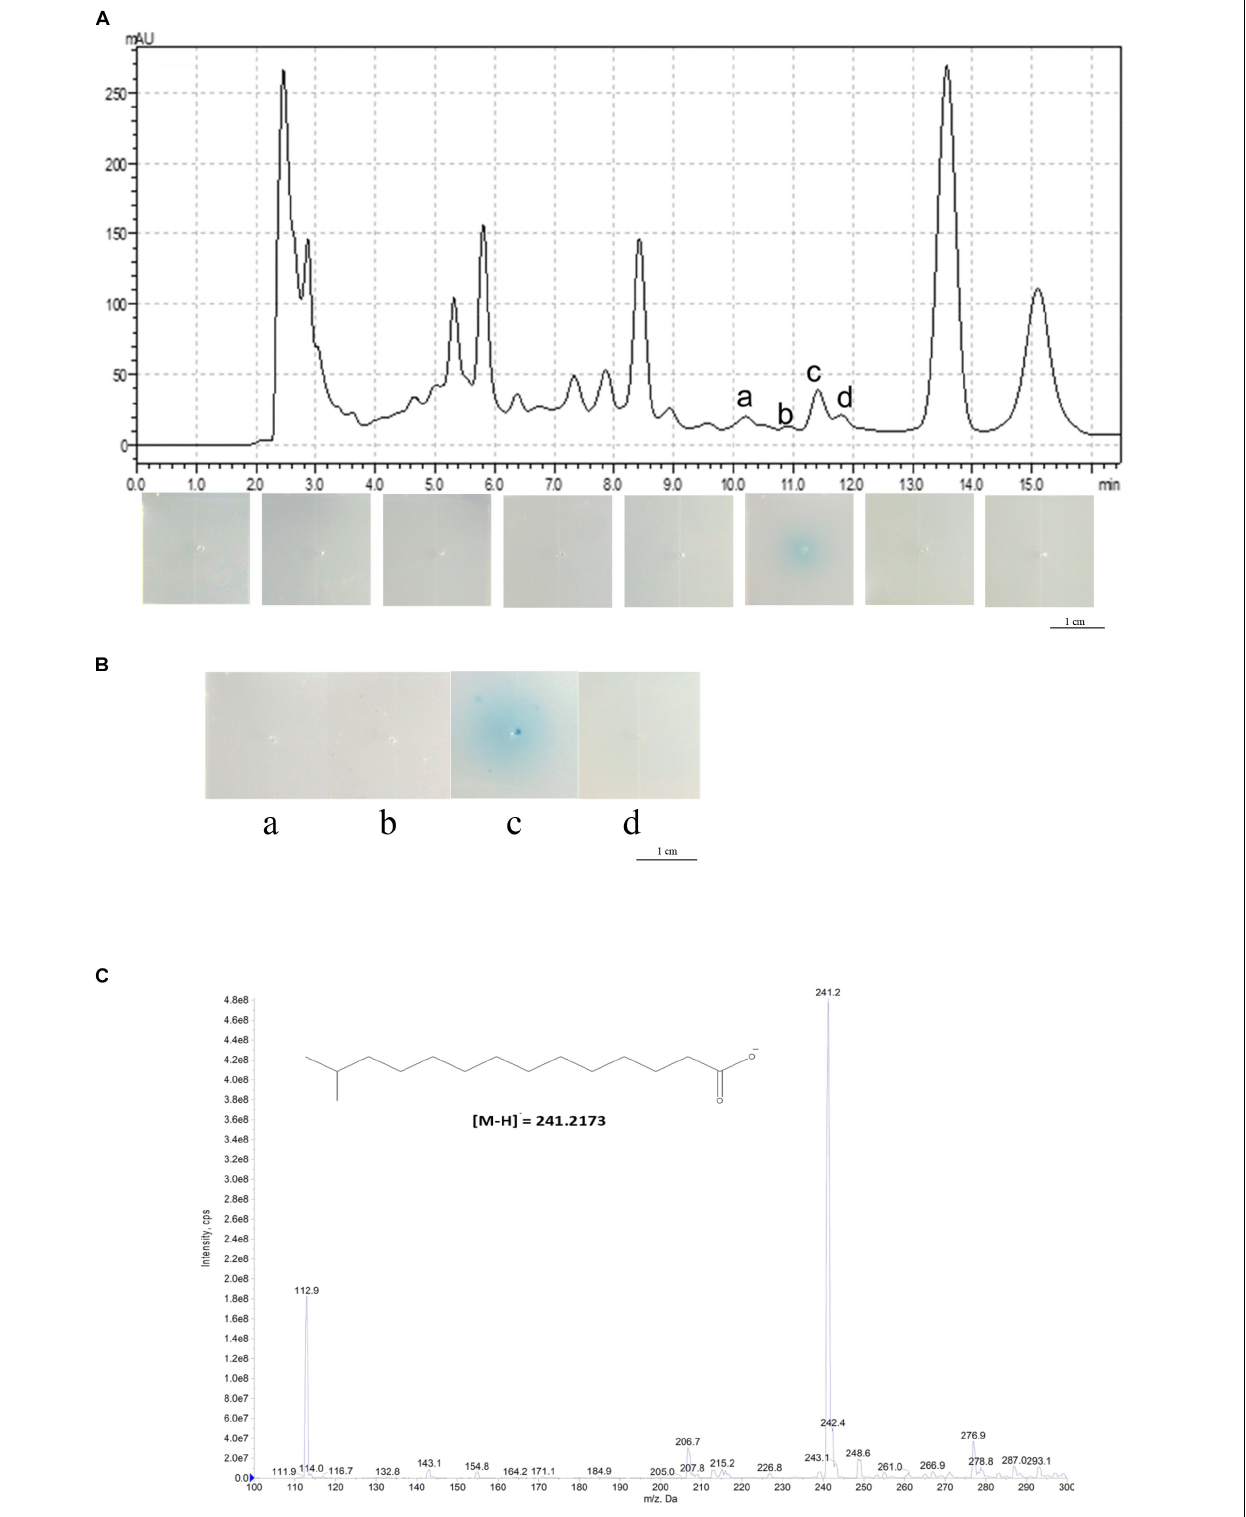
FIGURE 1 | Structural determination of the DSF from L. brunescens OH23. (A) HPLC analysis of the L. brunescens crude supernatant. (B) Bioassay of the four purified HPLC fractions a, b, c, and d from 10 to 12 min. The blue halo indicates DSF activity. (C) Mass spectrometry analysis of Le DSF3 (calculated [M − H] − = 241.2173 Da, observed 241.2